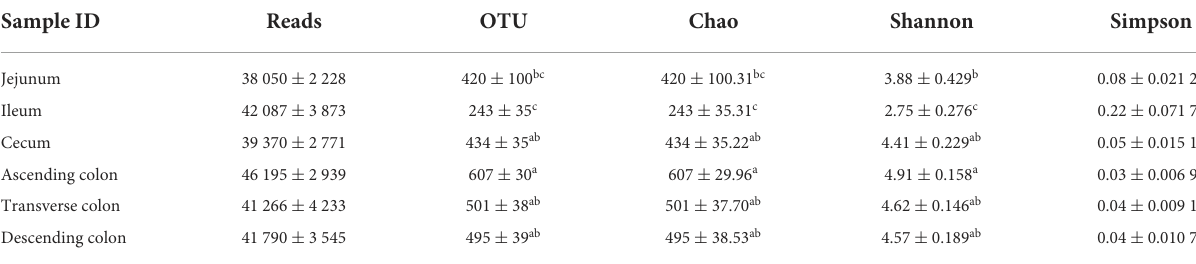
TABLE 2 Diversity of sequencing data of pig intestinal contents from different intestinal segments.